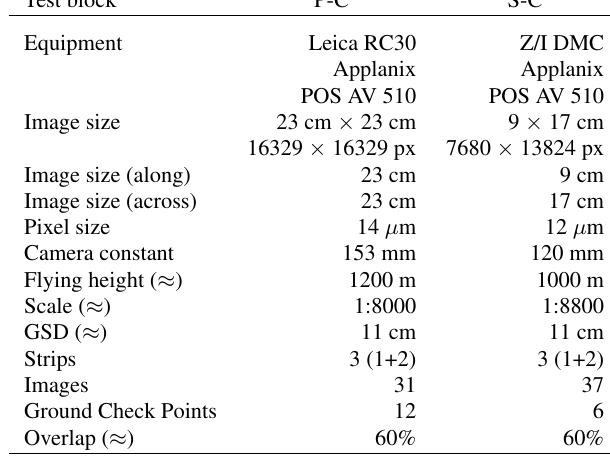
Table 2: Test blocks: geometric configuration. ISO Fast AT